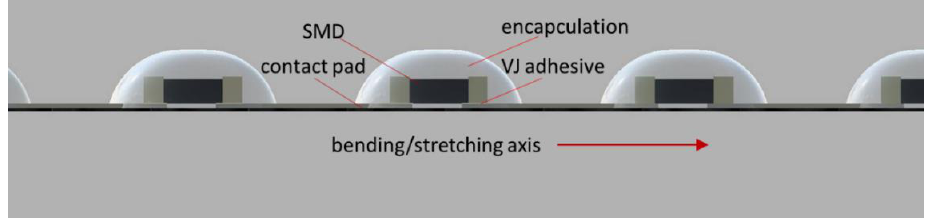
Figure 1. Schematic of diodes/resistors mounted on textile substrate